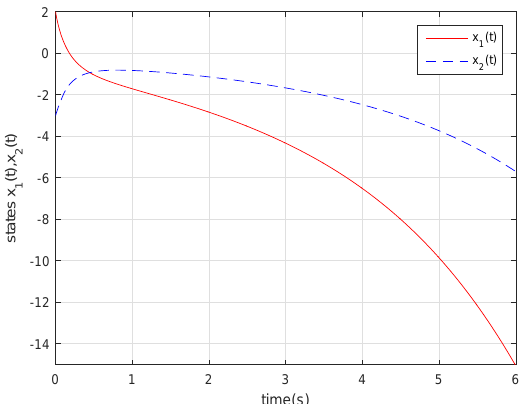
Figure 1. Time response of the selected systems without control input in the Example 1.